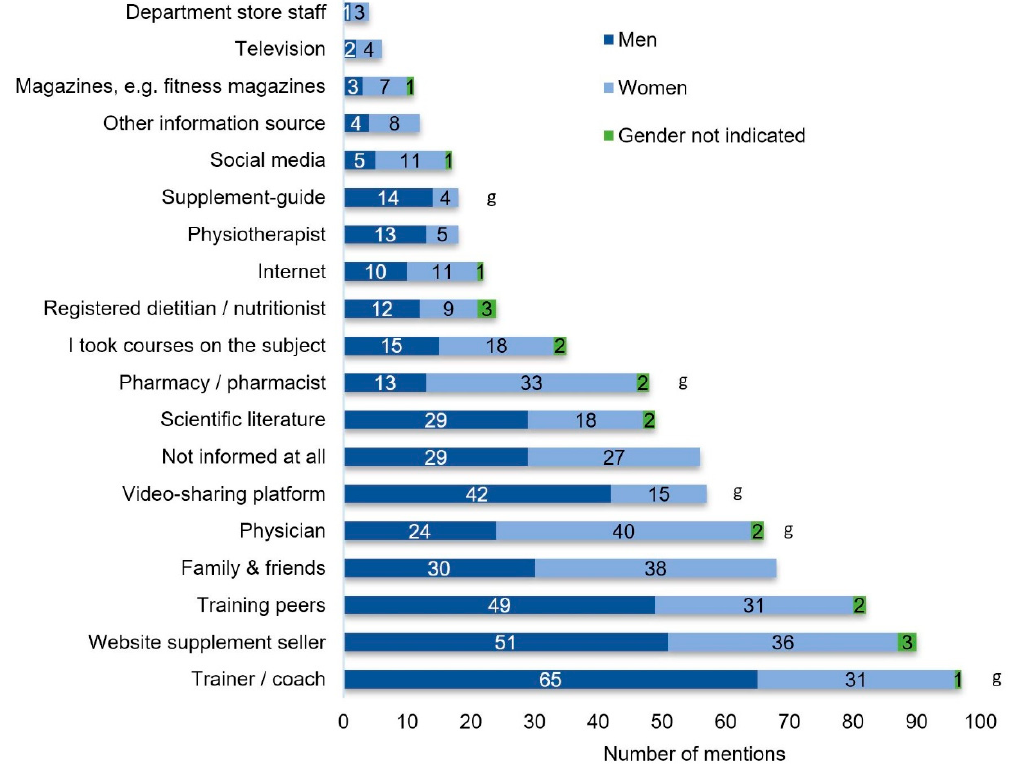
Figure 4. Indicated relevant information sources about supplements. Multiple answers were possible. g: Indicates significant gender effect ( p < 0.05).